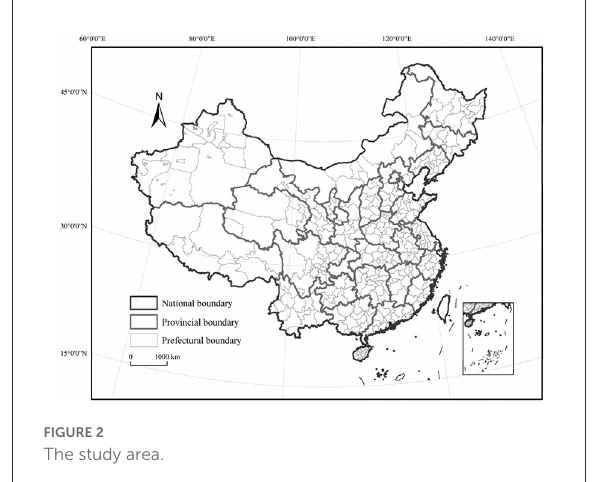
FIGURE2 The study area.